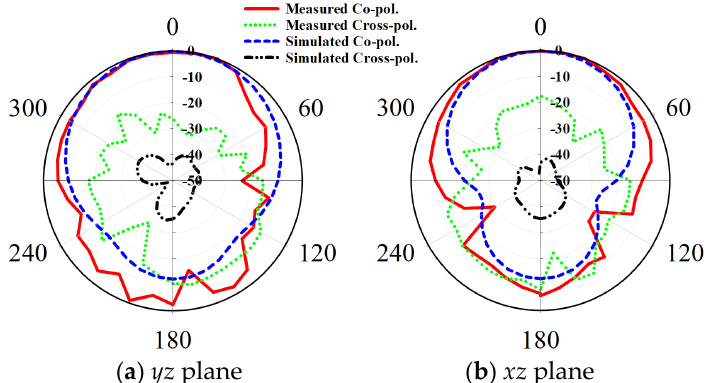
Figure 11. Normalized radiation patterns of aperture-fed antenna (2.44 GHz).